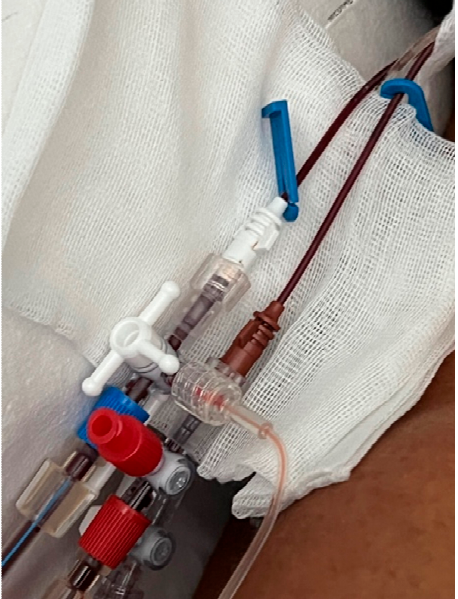
Figure 1. The 14 G lumen of the CVC was used as arterial line, and the 16 G lumen as venous line.